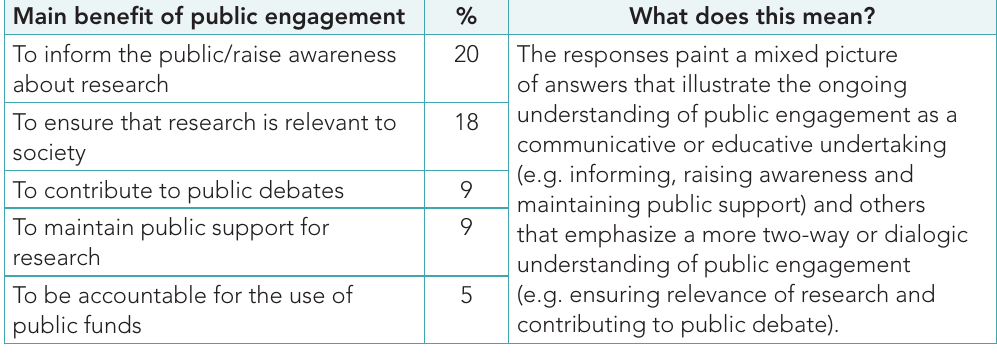
Table 3: Researchers’ judgements of the single main benefit of public engagement, top 5